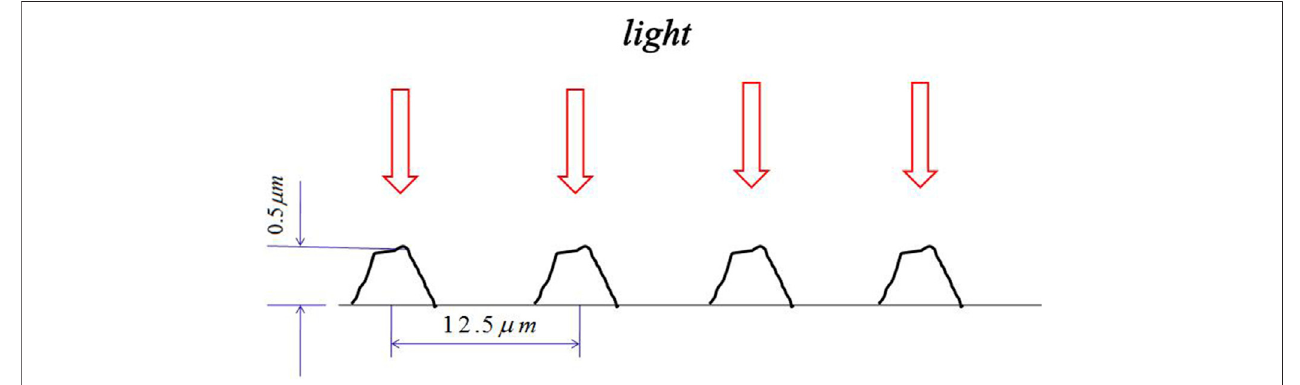
FIGURE 4 | Schematic diagram of the polar bear hair effect.